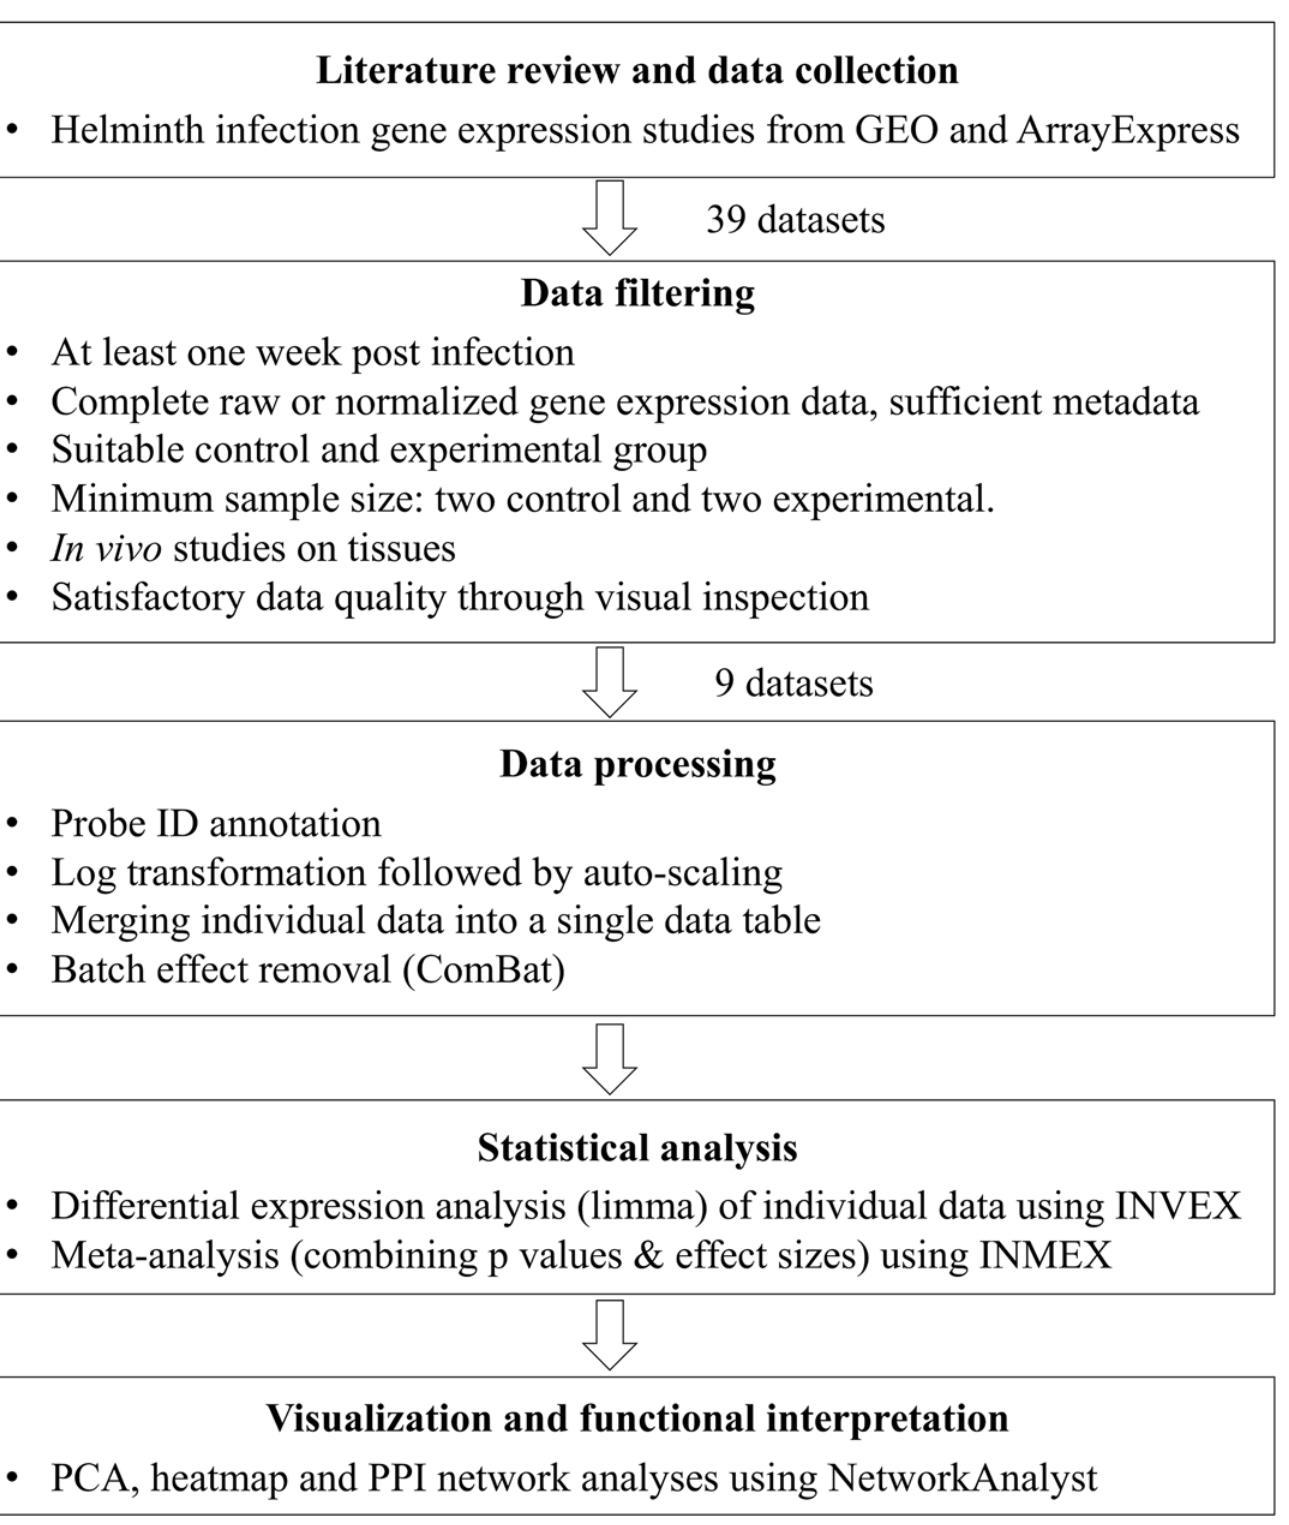
Fig 1. The meta-analysis flowchart. The process consists of five main stages. The main tasks in each stage are described in the corresponding box.